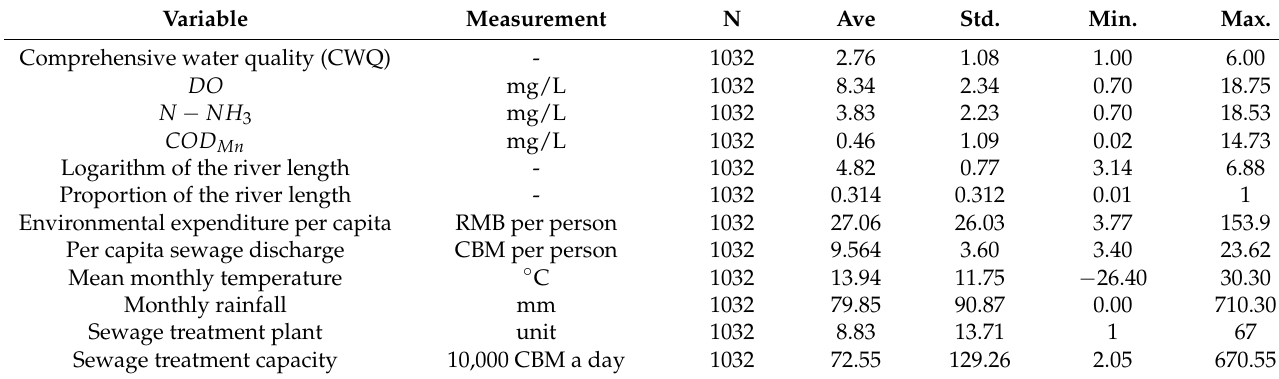
Table 3. Descriptive statistics of variables (monthly